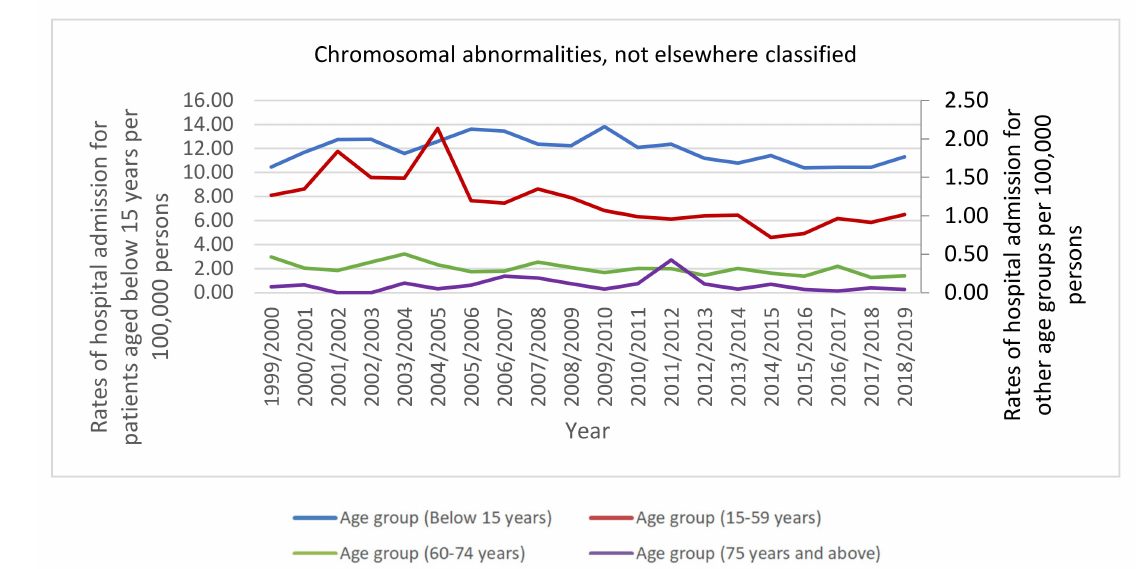
Figure 5. Hospital admission rates for congenital malformations, deformations and chromosomal abnormalities in England and Wales stratified by age group.